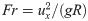
Optimality regions of rotational hopping strategy and rolling strategy.Regions of strategies with least energy loss to overcome an obstacle of height h as a function of the moment of inertia factor α = I/mR2, and the Froude number Fr=ux2/(gR). The results shown are independent of the mass of the wheel.